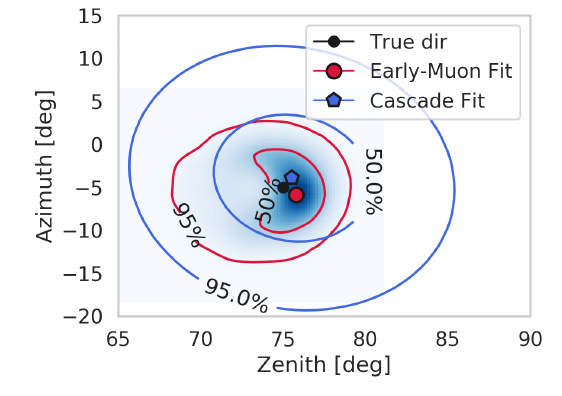
Figure 3. Angular reconstruction performance of the early muon reconstruction in comparison to the shower (cascade) only reconstruction for a multi-PeV hadronic shower. The blue-shaded region indicates the posterior PDF. The lines indicate 50% and 90% credible